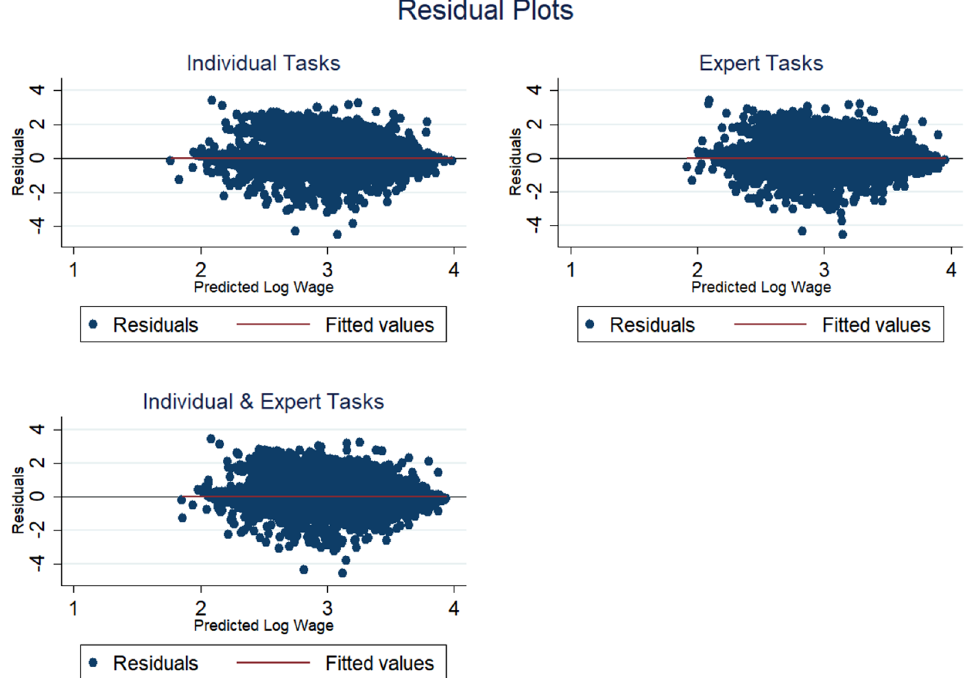
Fig. 1 Residual Plots of Wage Regressions containing Individual- and Expert-based Task Measures. NOTE.-The panels display residual plots of three regression models. The panel in the top left (“Indiv”) uses survey data at the individual-level. The panel in the top right (“Exp”) uses expert data at the occupation-level. The panel at the bottom (“Indiv & Exp.”) combines both task dimensions. I use BIBB/BAuA data that has been collected in 2011–12 and 2017–18, and data from the German Socioeconomic Panel (SOEP) from the 2011, 2012, 2017, and 2018 surveys. For the BIBB/BAuA data, see Hall et al. (2020b) and (Hall et al. (2020a), respectively. For the BERUFENET data, see Dengler et al.